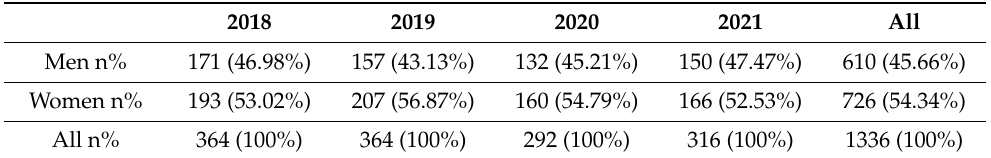
Table 1. The incidence of uveal melanoma in the national referral center in Poland between 2019 and 2021.